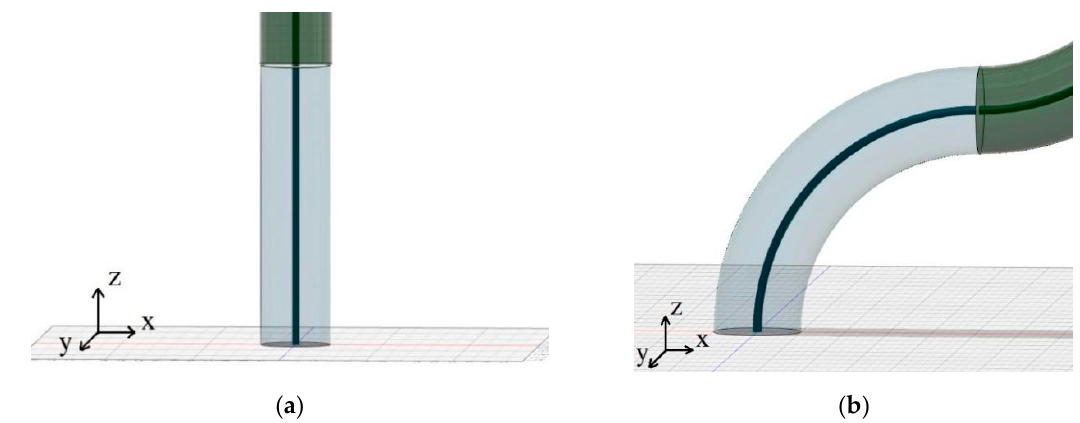
Figure 2. Continuum robot one-segment bending motion: ( a ) robot segment in a vertical position; ( b ) the robot segment is bent.